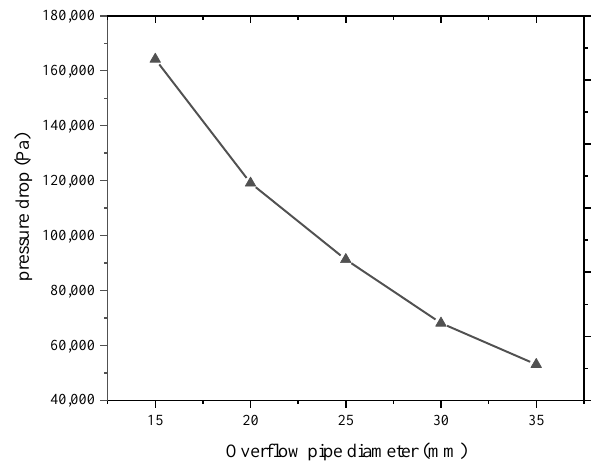
Figure 10. The pressure drop.